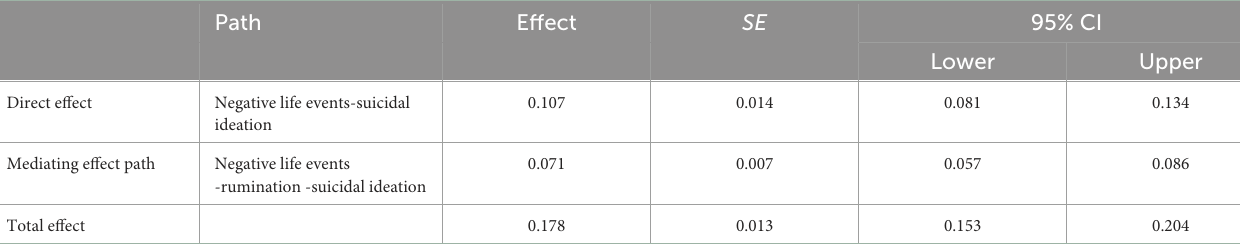
TABLE 4 Descriptive statistics and correlations between